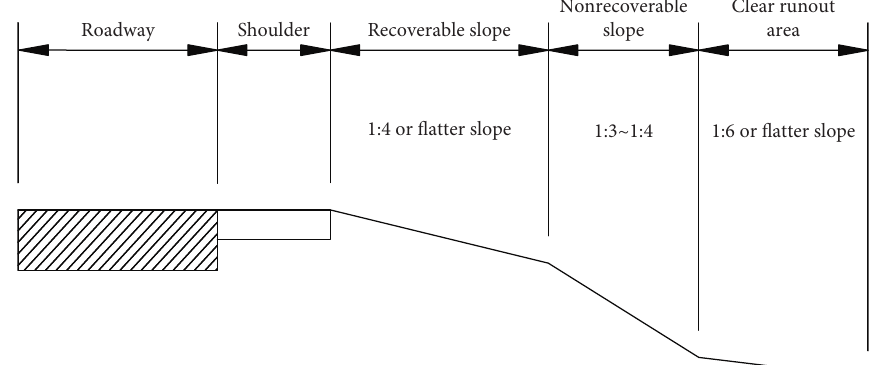
Figure 1: Standard setting of the roadside slope.